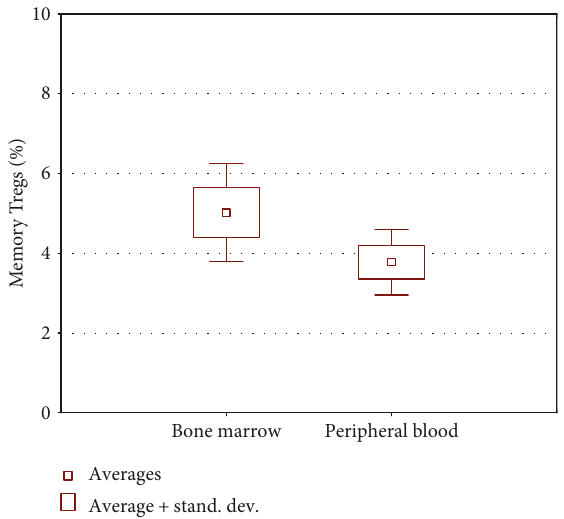
Figure 4: Statistical analysis of selected Treg subpopulations in analyzed population of ALL